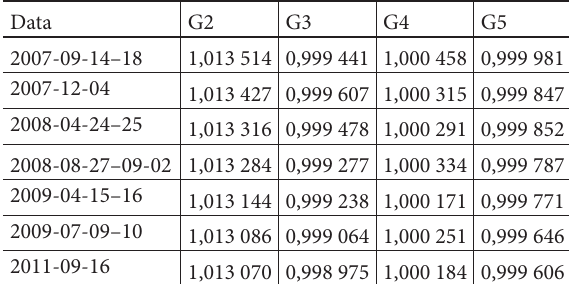
Fig. 2. The changes of the linear scale coefficients 1 lentelė. Vidutinės kalibravimo koeficientų reikšmės Table 1. Mean values of the linear scale coefficients Data